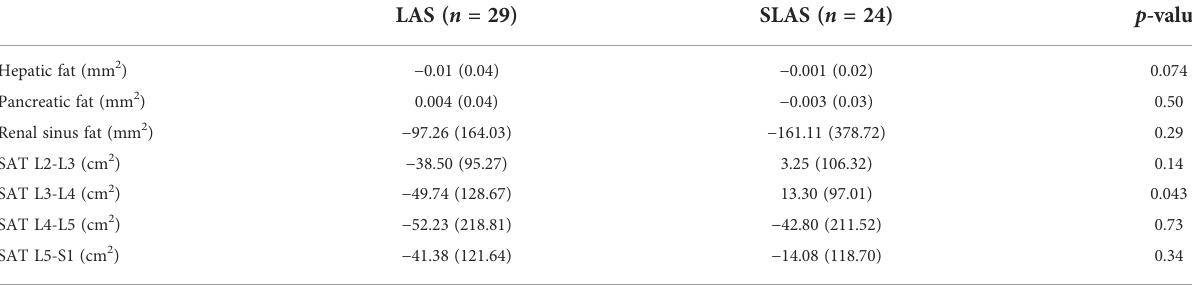
TABLE 5 Change in visceral adipose tissue and subcutaneous adipose tissue after the